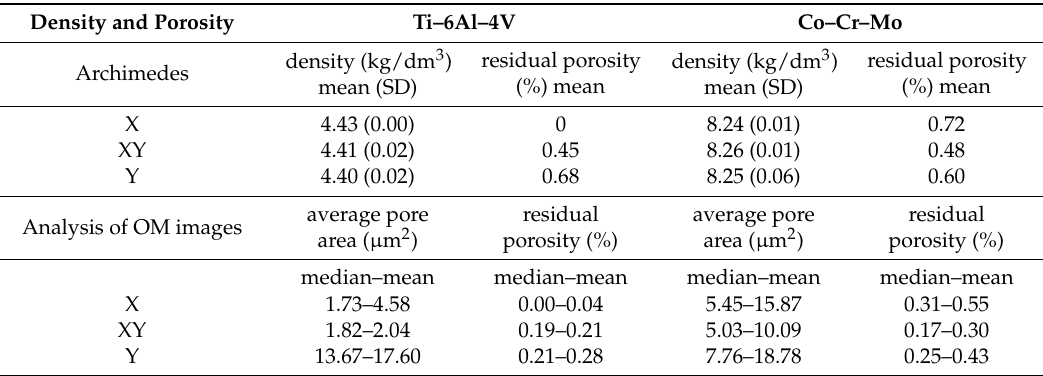
Table 3. Density and porosity determined by the Archimedes principle and by OM observations. For Archimedes measurements, standard deviations are given in brackets next to the mean values computed over 6 measurements. For the results obtained by OM, median and mean values are provided.